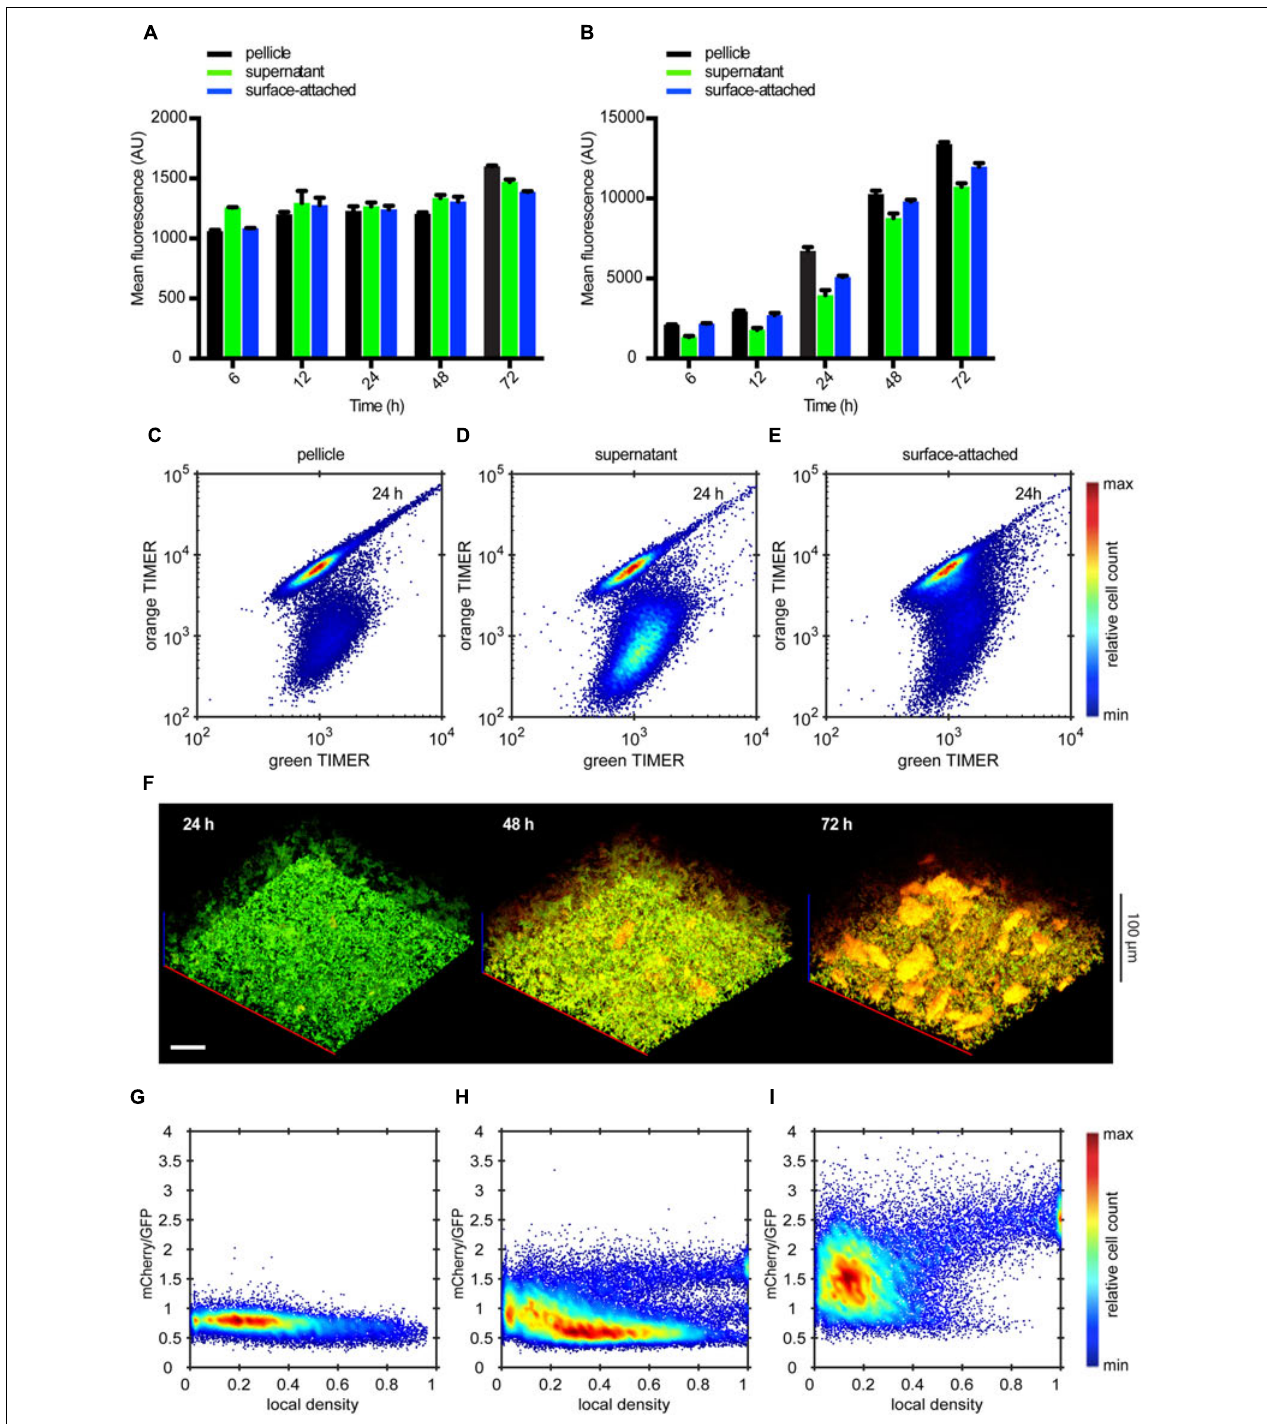
FIGURE 7 | Molecular timer analysis shows temporal accumulation of slow-growing cells in submerged static biofilms. (A − B) Mean fluorescent intensity of fast-maturating green TIMER molecules (A) and slow-maturating orange TIMER molecules (B) in indicated cell fractions by flow cytometry. (C − E) Scatter plots showing expression of green TIMER molecules and orange TIMER molecules in (D) pellicle, (E) supernatant, and (F) surface-attached cells at 24 h. The color scale shows relative cell count from lowest (blue) to highest (red). (F) Confocal fluorescence microscopy images (maximum projection) showing fast-growing cells (green) and slow-growing cells (red) at 24, 48, and 72 h of biofilm growth (from right to left). Scale bar, 40 µ m. (G − I) Expression profile of orange TIMER as a function of local density in submerged biofilms shown in (F) at 24 h (G) , 48 h (H) , and 72 h (I) of growth. Values of orange TIMER fluorescence are normalized to the internal control of green TIMER. The color scale shows relative cell count from lowest (blue) to highest (red).